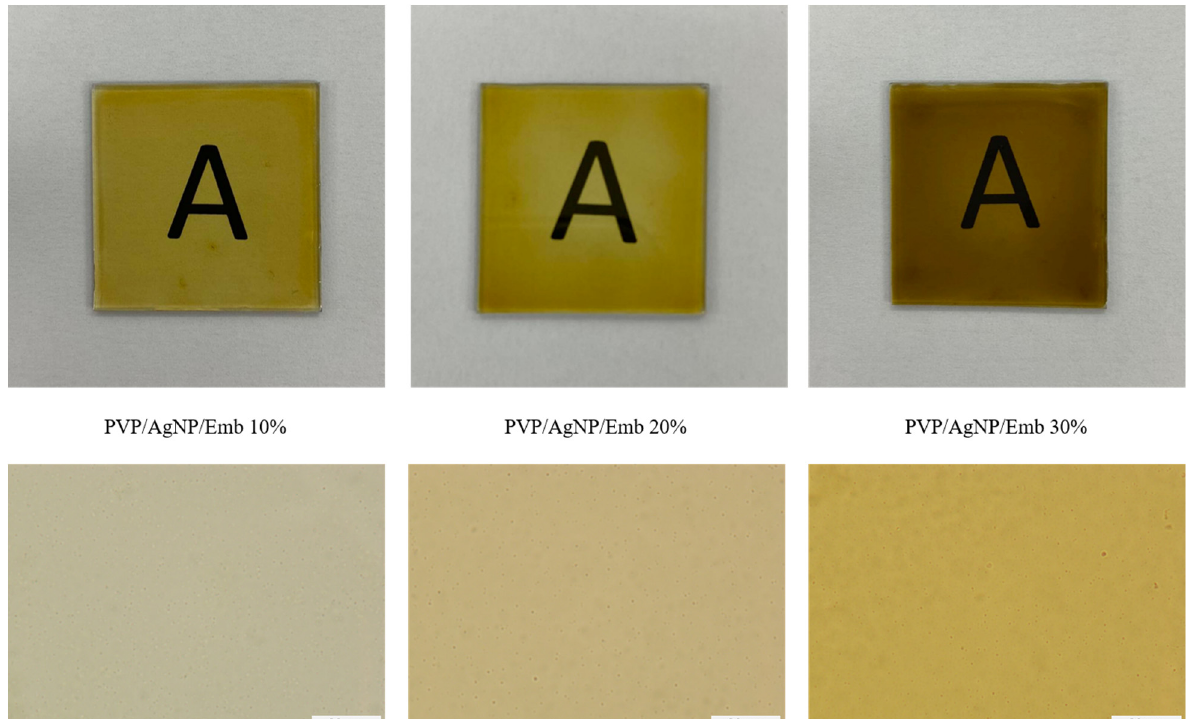
Figure 7. Optical images of spray-on films loaded with different amounts of Phyllanthus emblica ex- tract on glass slides and their surface morphology obtained using a digital microscope at 100× mag- nification.